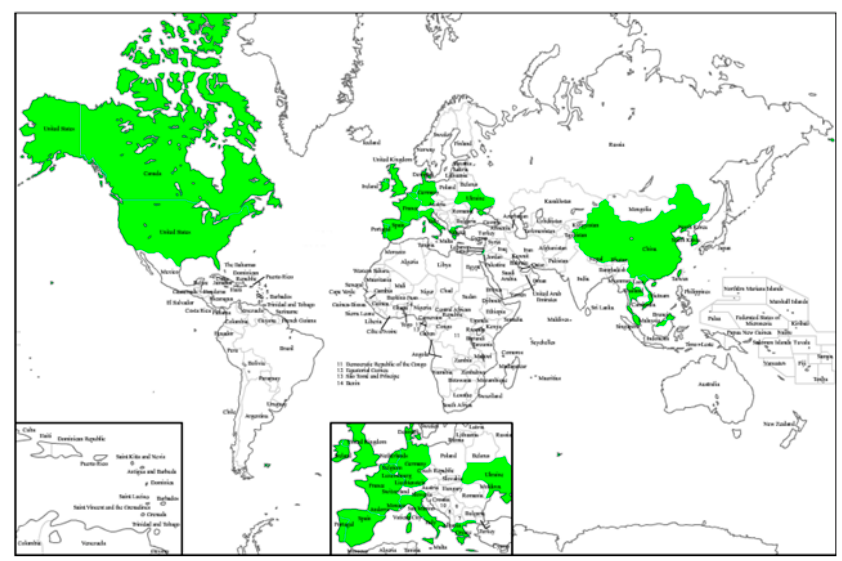
Figures 2. Regions of the world where it is possible to cultivate S . rebaudiana . Figure 2. Regions of the world where it is possible to cultivate S . rebaudiana .